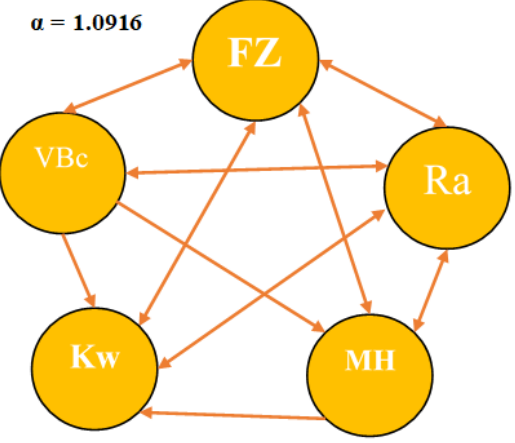
Fig. 3. DEMATEL diagraph for responses